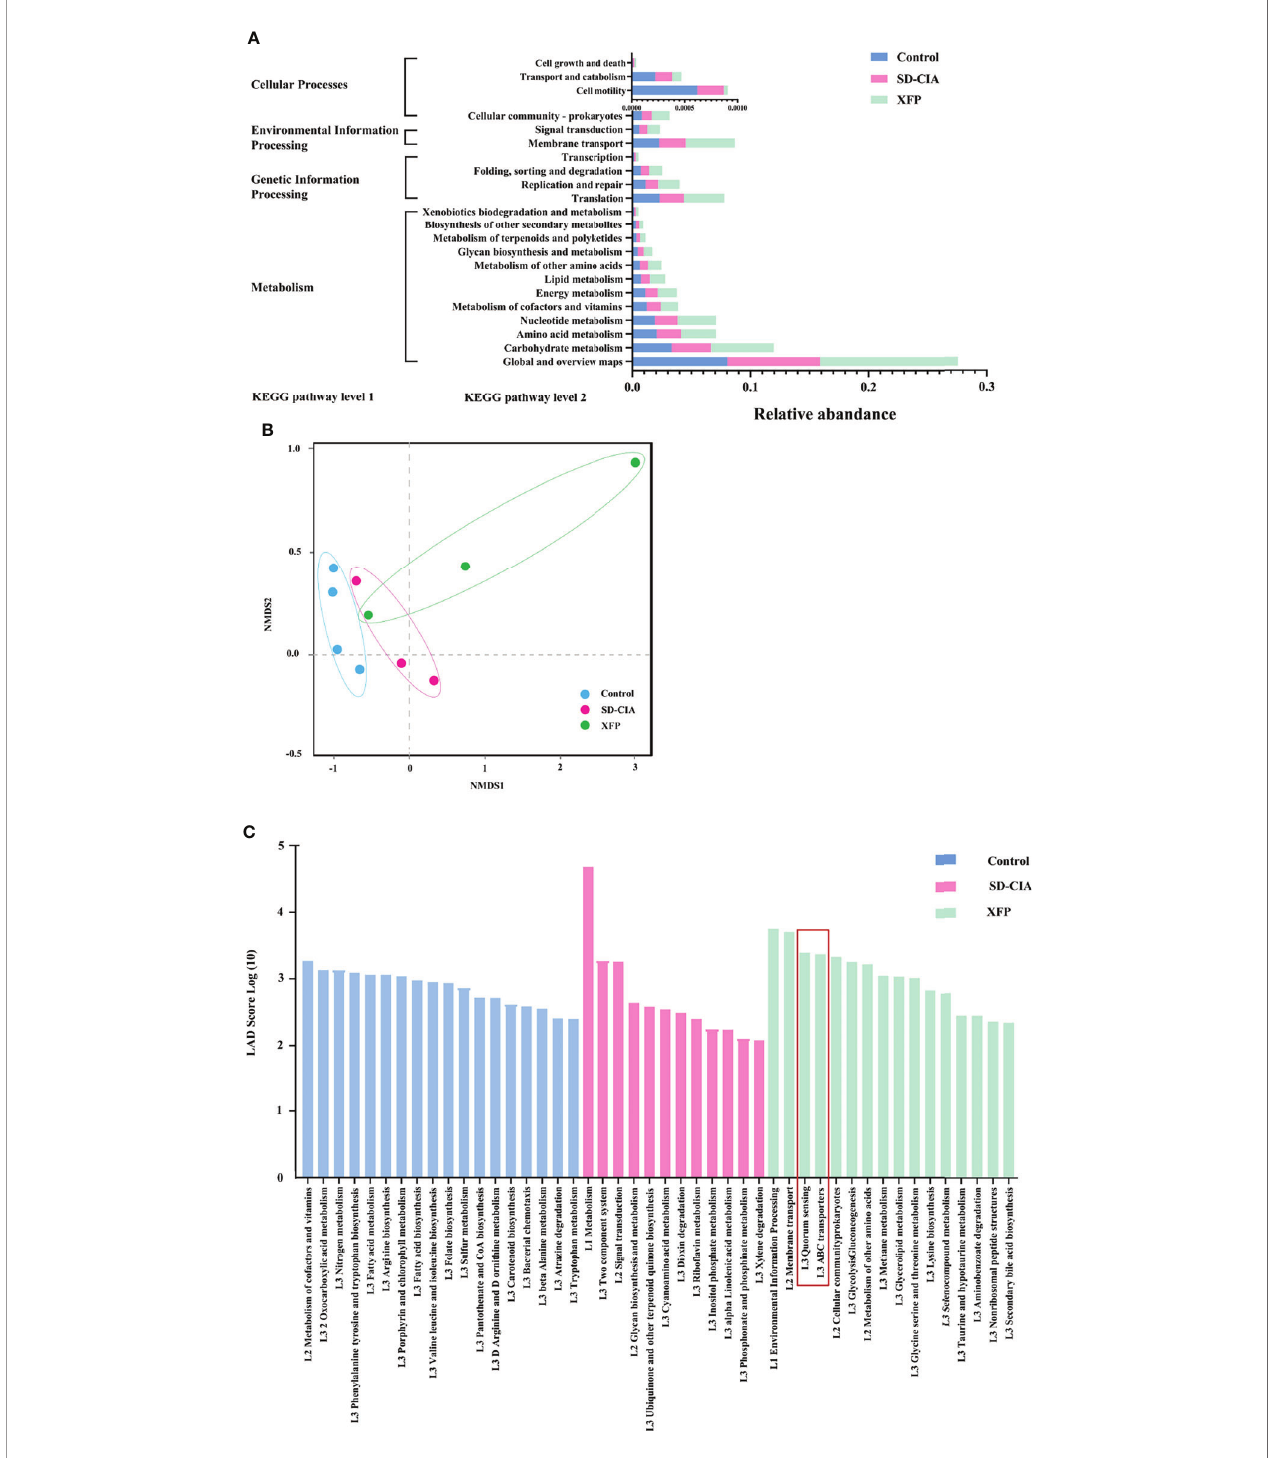
FIGURE 7 | Effect of XFP on the function of gut microbiota in ileum contents. (A) Statistical map of KEGG metabolic pathway-related functional genes at level 2 in each group. (B) The differences in gut microbial communities among the groups by NMDS. (C) Diagram of the function of gut microbiota using LEfSe analyses. The data were transformed by log (10) . n = 4 (control), n = 3 (SD-CIA and XFP). XFP, Xiong Fu powder; SD-CIA, collagen-induced arthritis with spleen de fi ciency; NMDS, non-metric multidimensional scaling; LEfSe, linear discriminant analysis effect size; LDA, linear discriminant